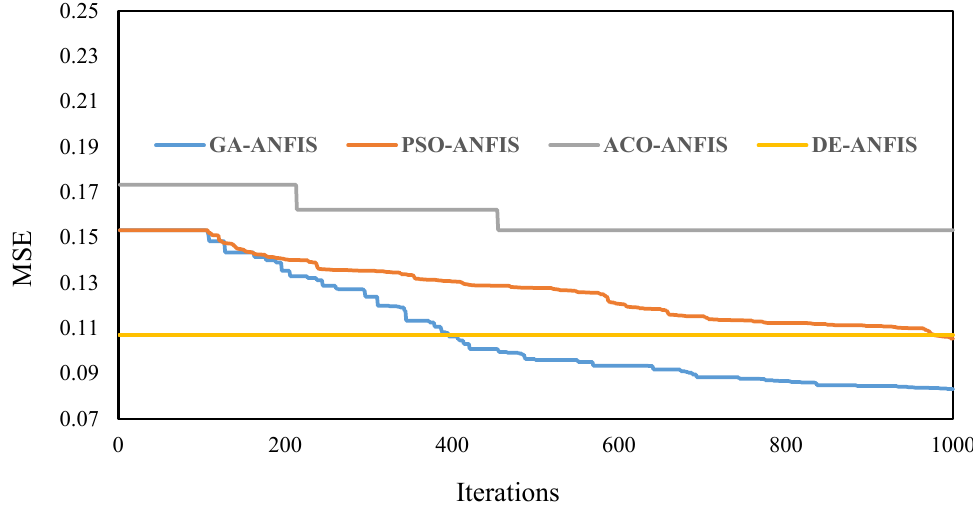
Figure 5. The convergence curves of the cost functions for the used models.